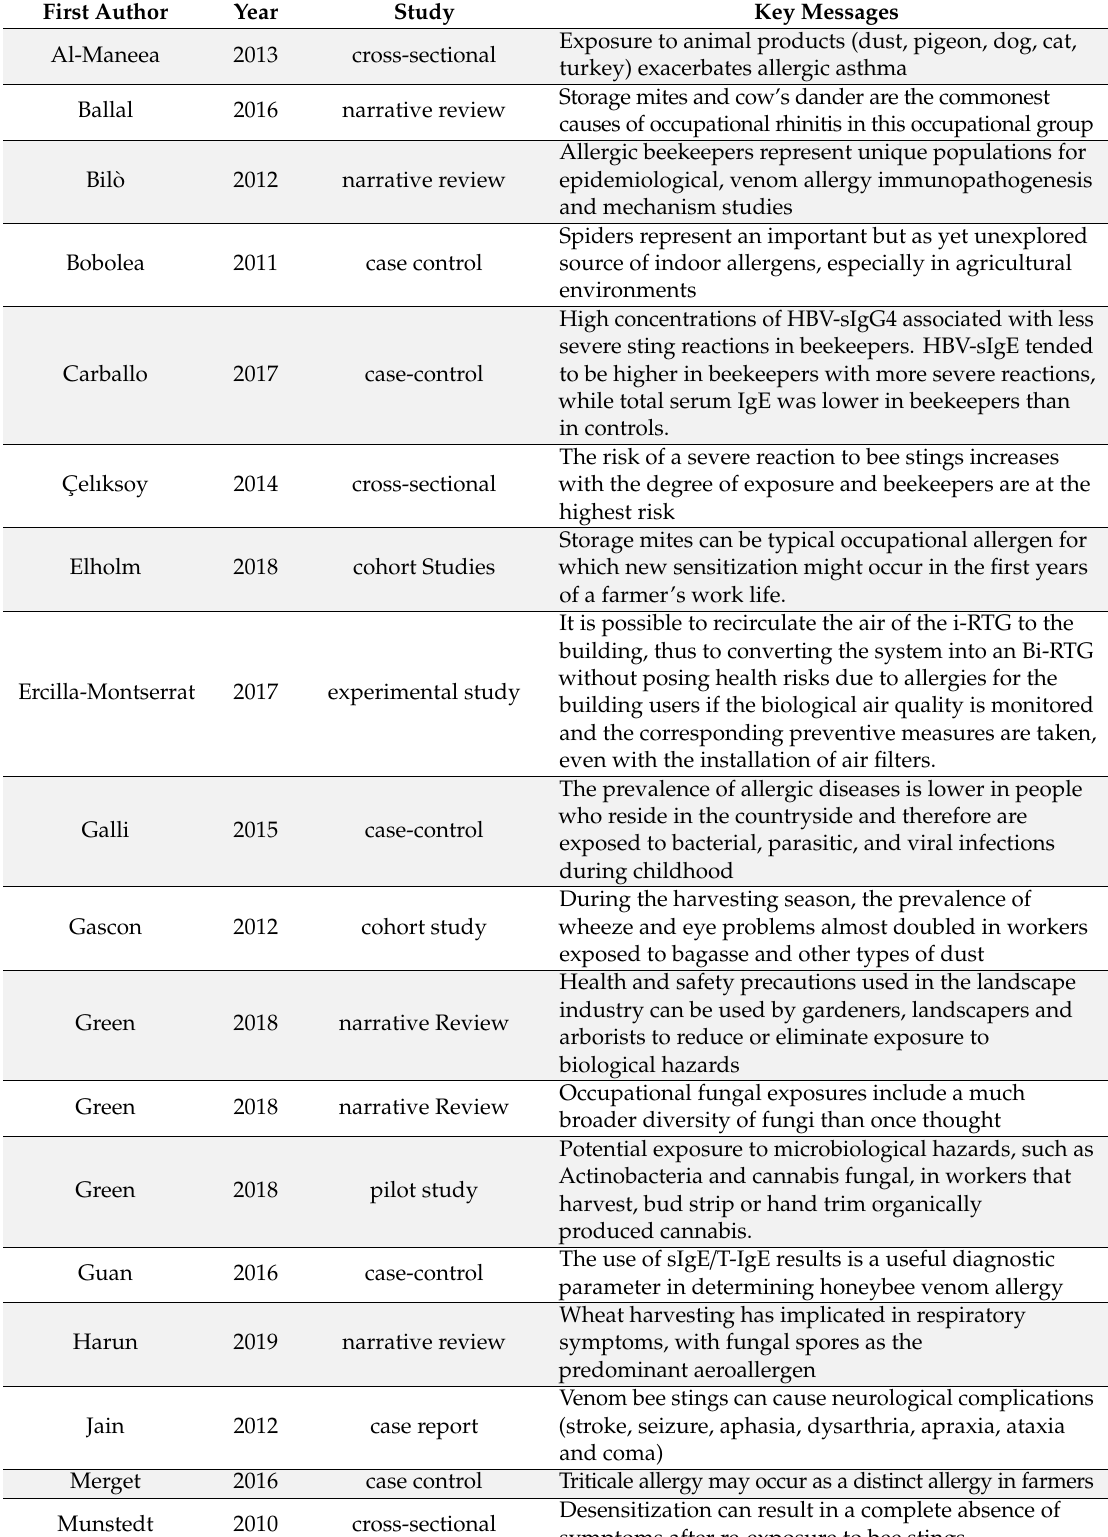
Table 1. The studies included in this systematic review, (in alphabetical